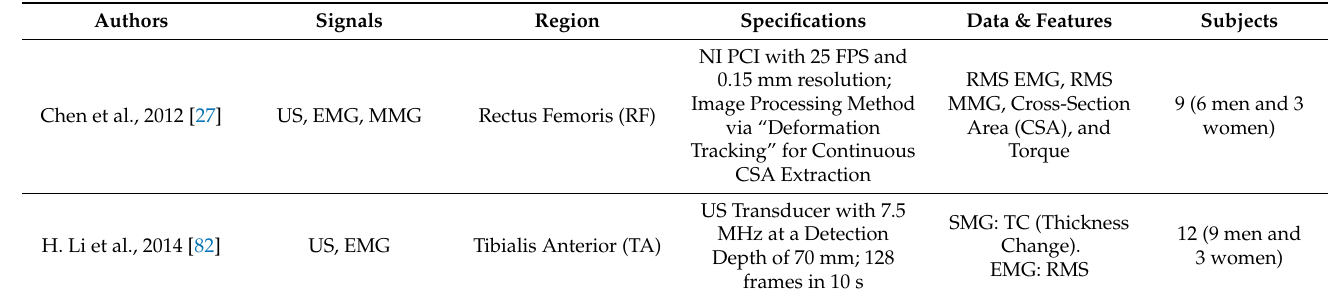
Table 2. Summary of Physiological